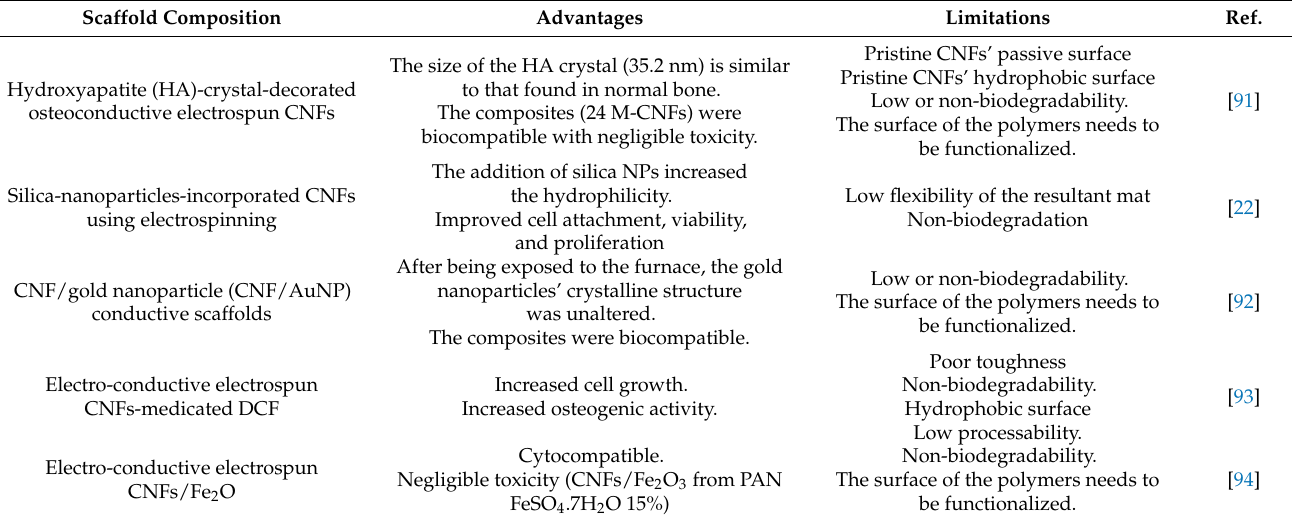
Table 1. Examples of some nanofibers-based scaffolds for bone tissue regeneration. Scaffold Composition Advantages